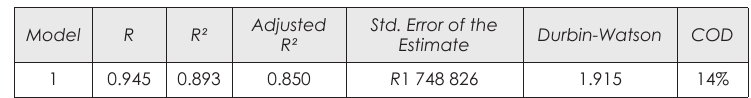
Summary of statistical indicators, Model